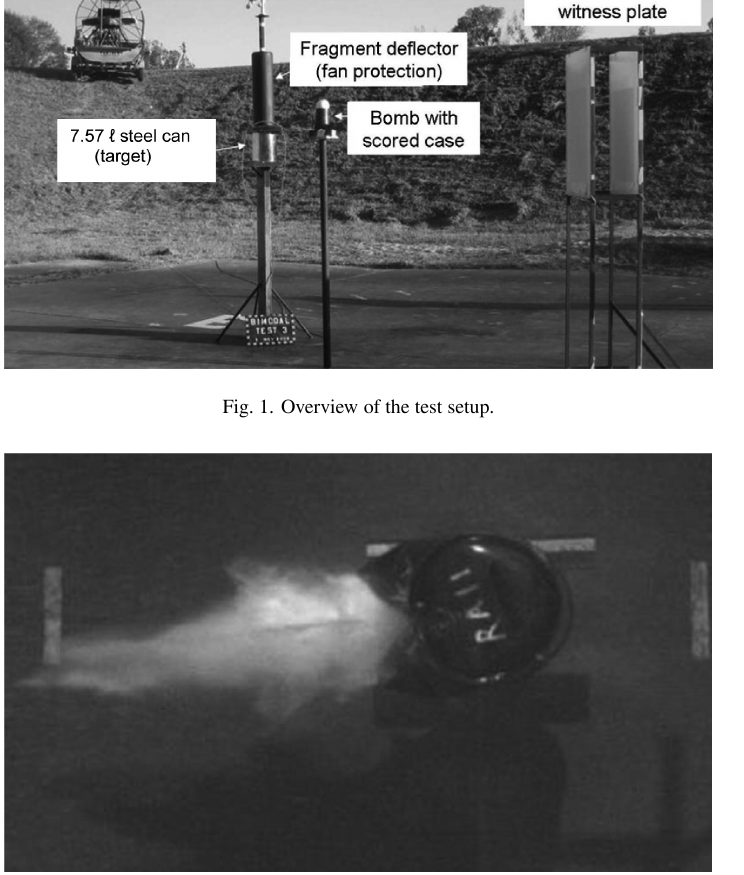
Fig. 2. Hydraulic ram (bomb location was to the left of this